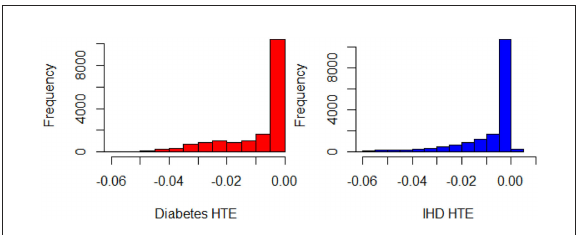
FIGURE2 τ C _ ML i for Diabetes and IHD, all observations in the Histograms of ˆ representative population (N 17,242). =